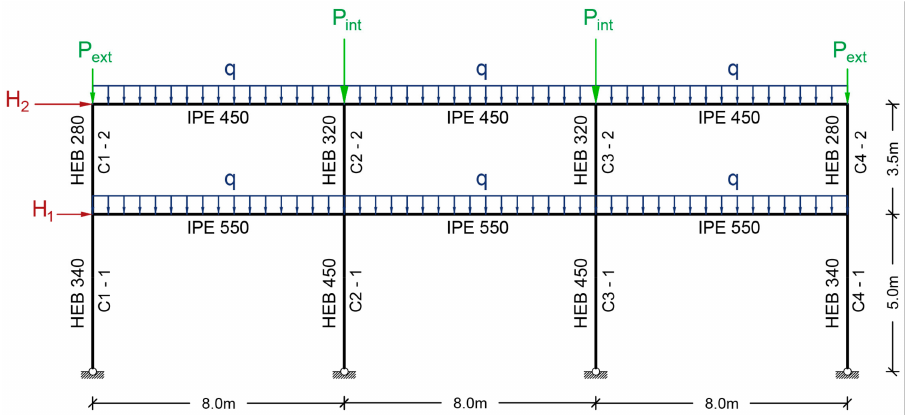
Figure 3. Configuration and load pattern of the examined frames and designation of their